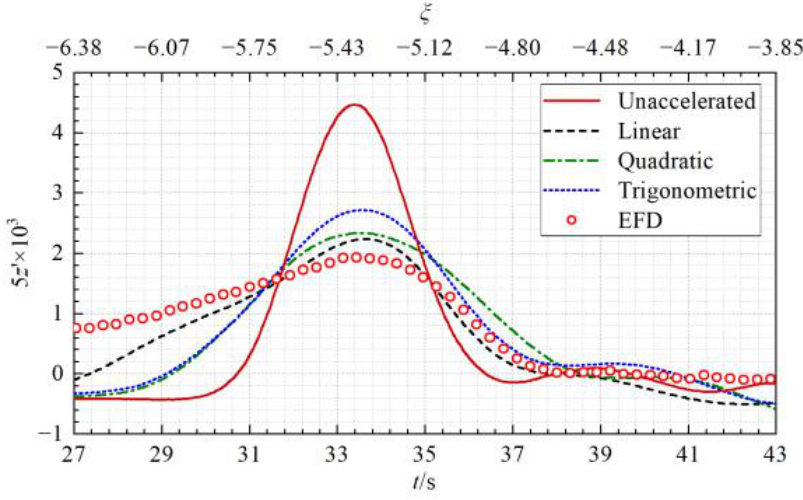
Figure 9. Time histories of free-surface elevations at the wave gauge position under the impacts of the solitary wave system.